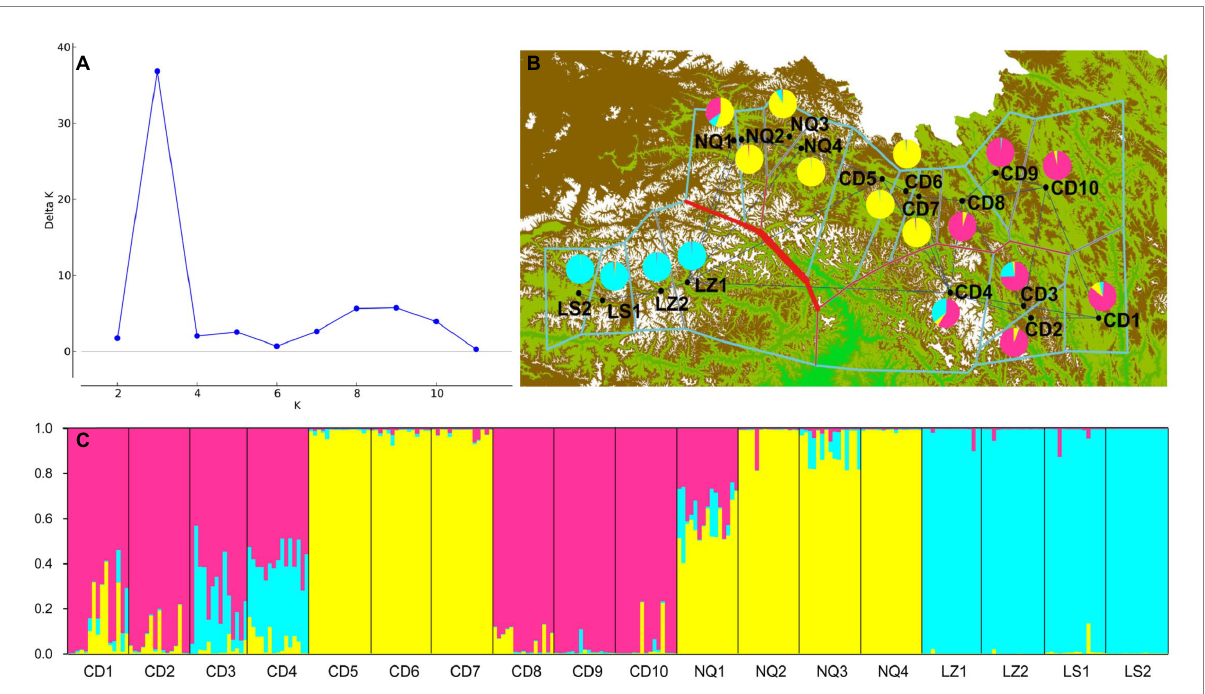
FIGURE 5 Results of STRUCTURE and BARRIER analysis among the E. breviaristatus populations based on EST-SSRs. (A) K model with an elevated Δ K values calculated for K varying from 2 to 18. (B) Bold red lines in the map represented the genetic’ barrier revealed by BARRIER, which divided 3 different gene pools. (C) Clustering patterns of the 269 individuals from the 18 E. breviaristatus populations using made by STRUCTURE for K = 3, each individual is represented by a vertical, colored line.